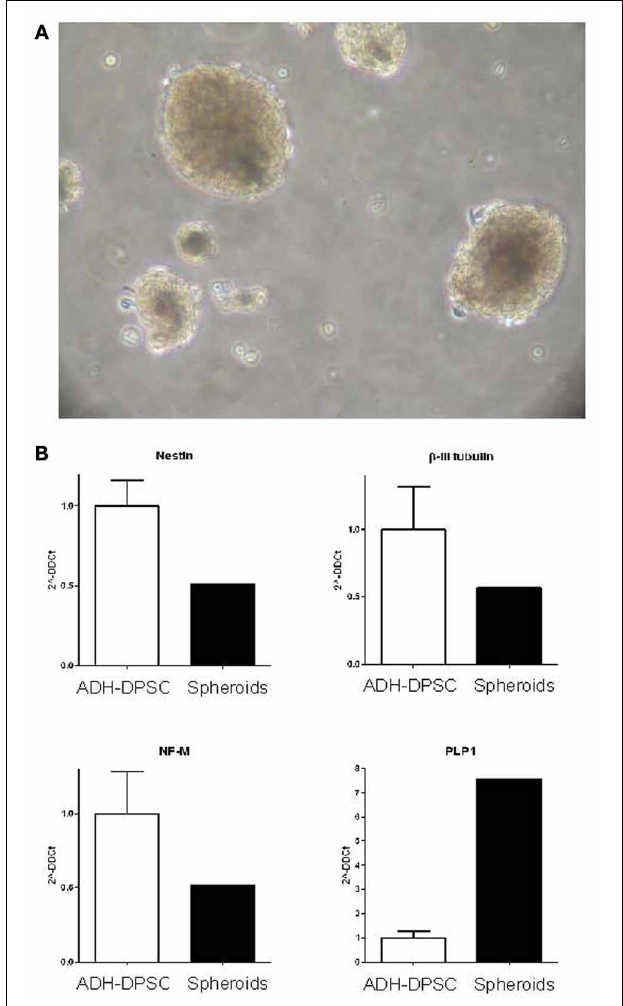
FIGURE 5 | Characterization of spheroid clusters. (A) Phase contrast microscopy of the spheroid structures derived from the non-ADH cell population after 10 days in culture (Scale bars = 40 μ m). (B) Real time quantitative PCR of neuronal marker expression (Nestin, β -III tubulin, NF-M) and oligodendrocyte marker PLP1 expression in the spheroid structures in comparison with ADH-DPSCs.